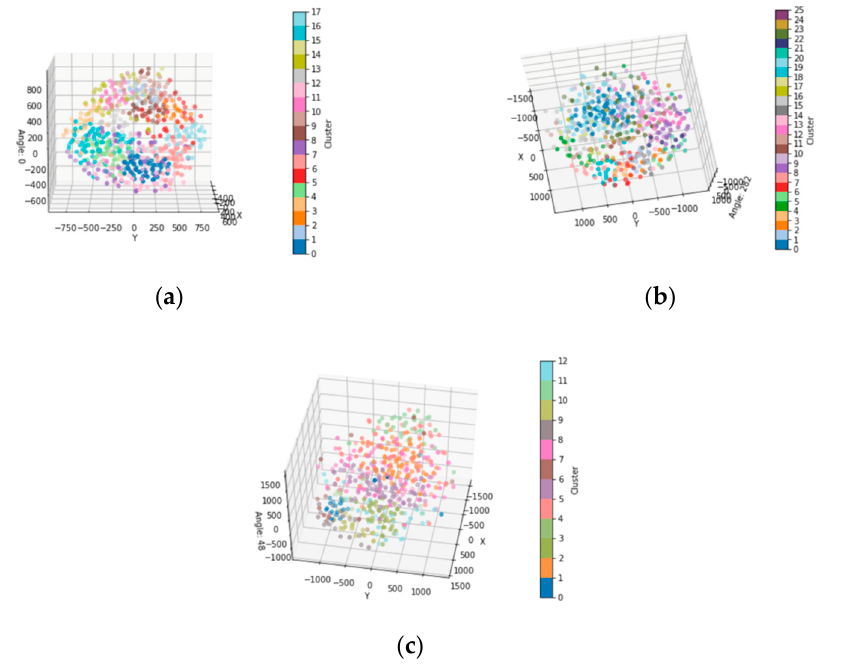
Figure 12. Visualization of embeddings cluster. ( a ) Cluster of embeddings in MovieTweetings-latest dataset; ( b ) cluster of embeddings in MovieTweetings-100k dataset; ( c ) cluster of embeddings in DigitalMusic dataset.